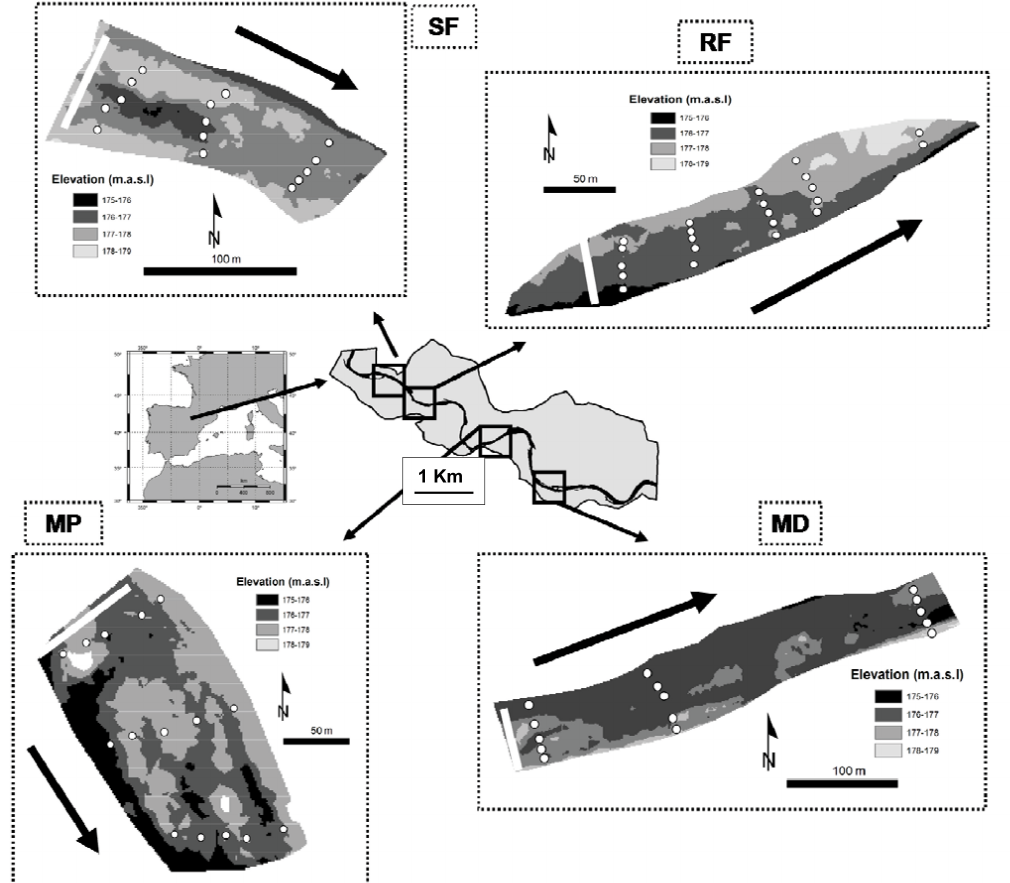
Fig. 1. Location of study plots along the four sites selected within the study reach, which are represented by a detailed Digital Elevation Model. Black arrows indicate the direction of the Ebro River flow. White circles represent the location of the study plots, reflecting an incremental distance to main channel along a perpendicular gradient. White solid lines at each site represent the area where surface water inputs the site, which has been the reference to calculate distances along a longitudinal gradient (see methods). Table 1. Description of sites where study plots were set.